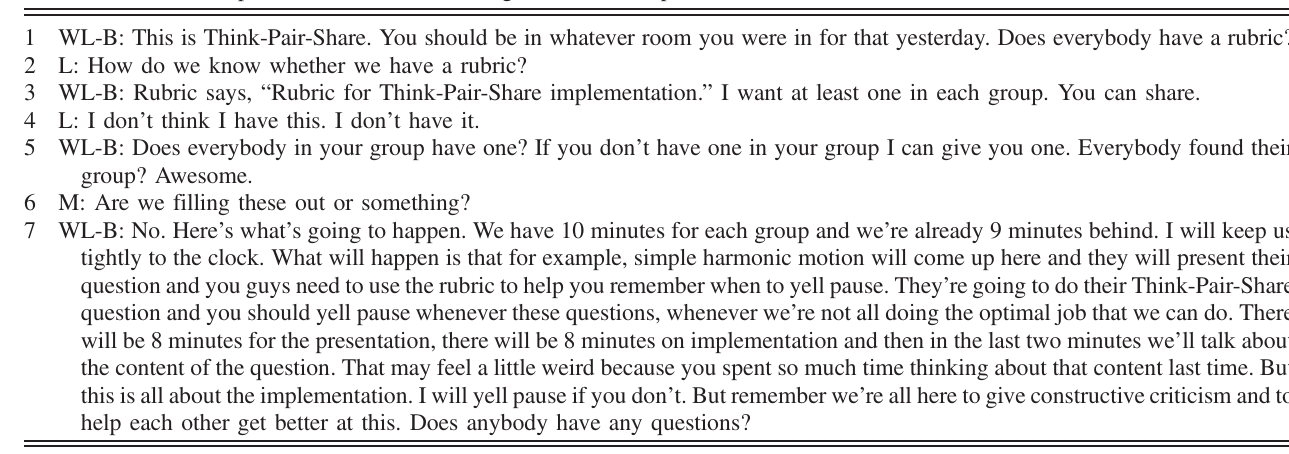
TABLE IX. Transcript of WL-B ’ s initial framing of the TPS implementation session, i.e., the first few minutes of Session B.